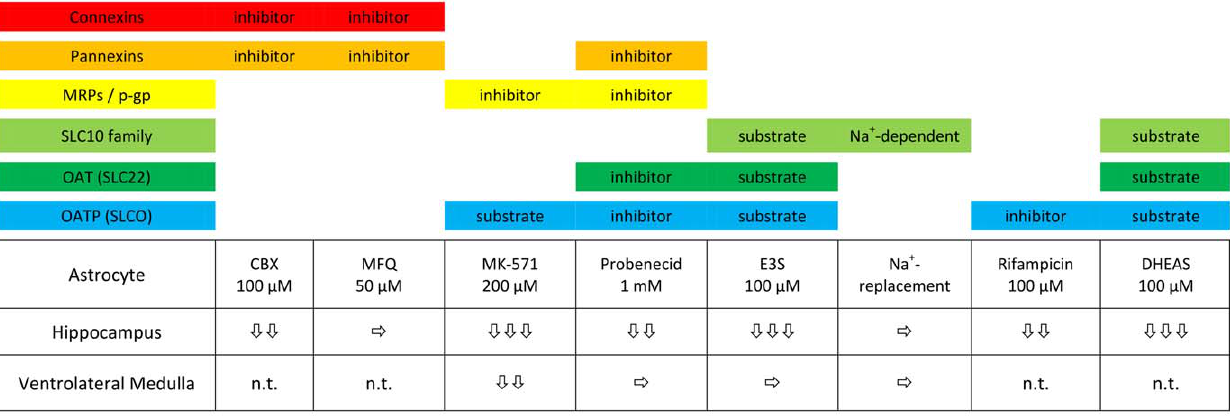
Figure 12. Pharmacological profile of astrocyte SR101-staining. Carbenoxolone (CBX); mefloquine (MFQ); estrone-3-sulfate (E3S); dehydroepiandrosterone sulfate (DHEAS); not tested (n.t.); very strong reduction of intensity ( KKK ), strong reduction ( KK ), moderate reduction ( K ), unchanged ( I ).